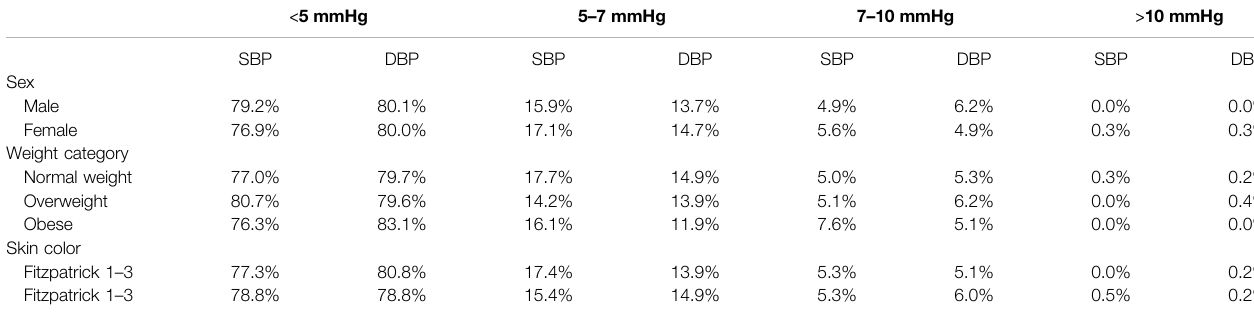
TABLE 2 | Level of agreement between the PPG-based wearable measurements across commonly accepted standard.